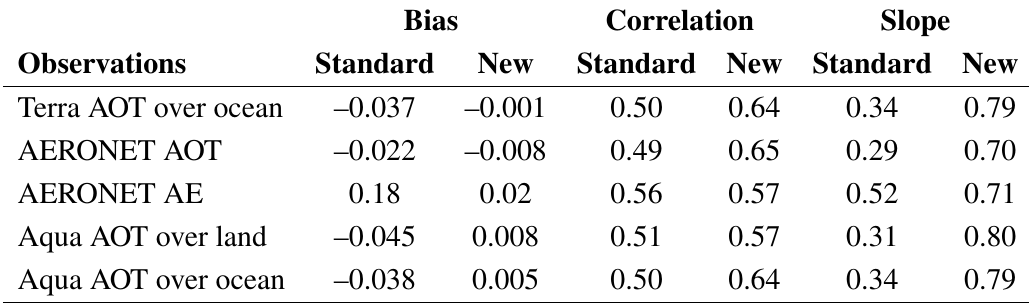
Table 1. Statistics for the comparison of the forecasts with observations for the standard and new